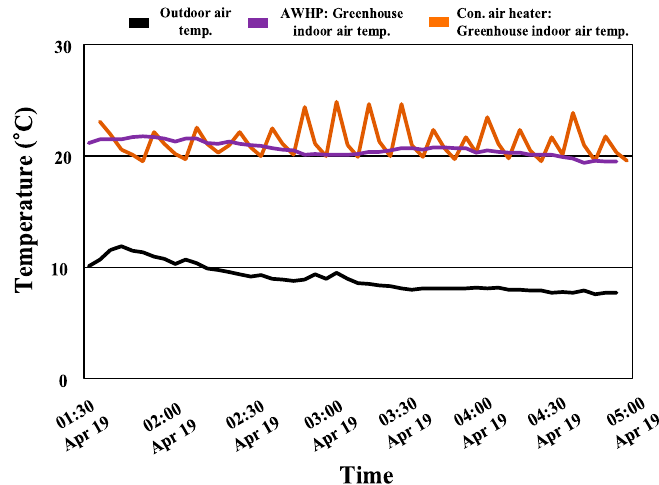
Figure 5. Comparison of heating performance between the AWHP and a conventional air heater.